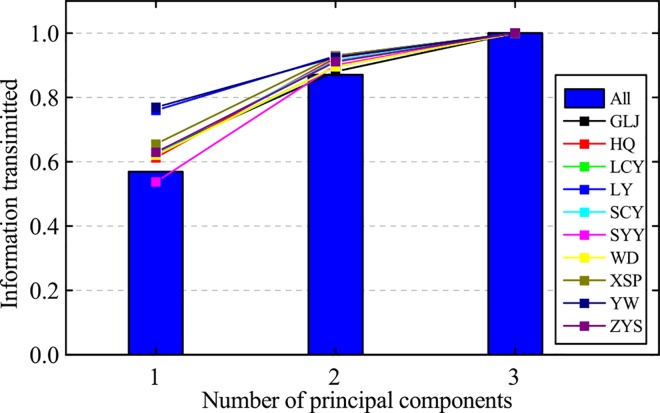
Information transmitted by PCs of wrist postures to each subject and all ten subjects.The abbreviations represent the name of each subject.